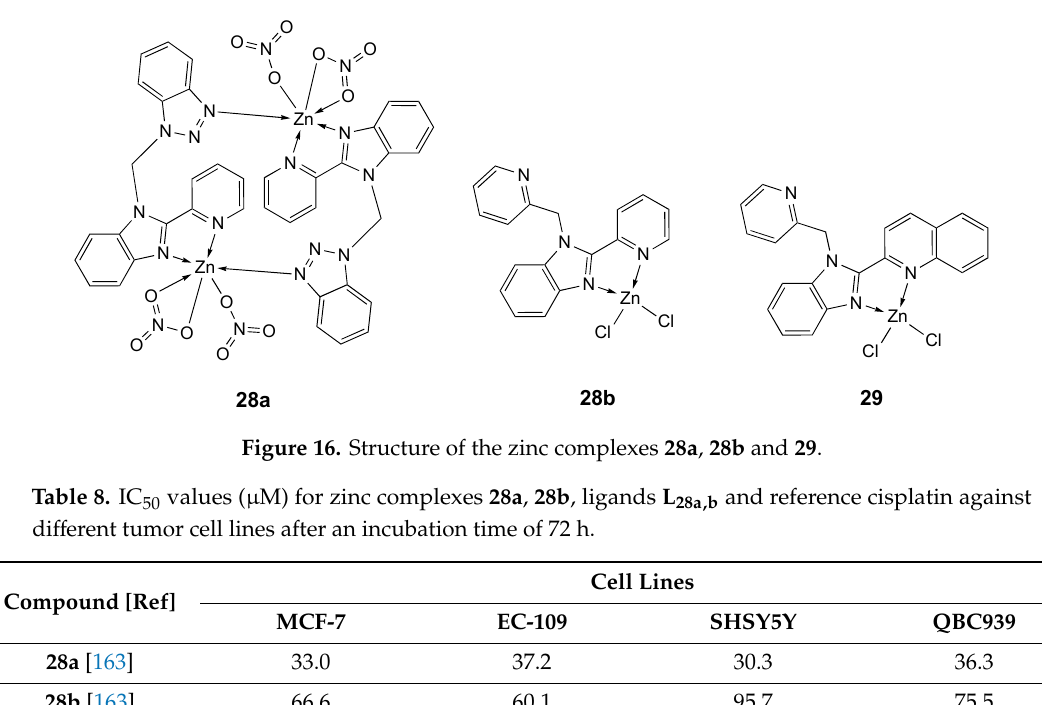
Figure 15. Structure of the zinc complexes 26a – c and 27 .